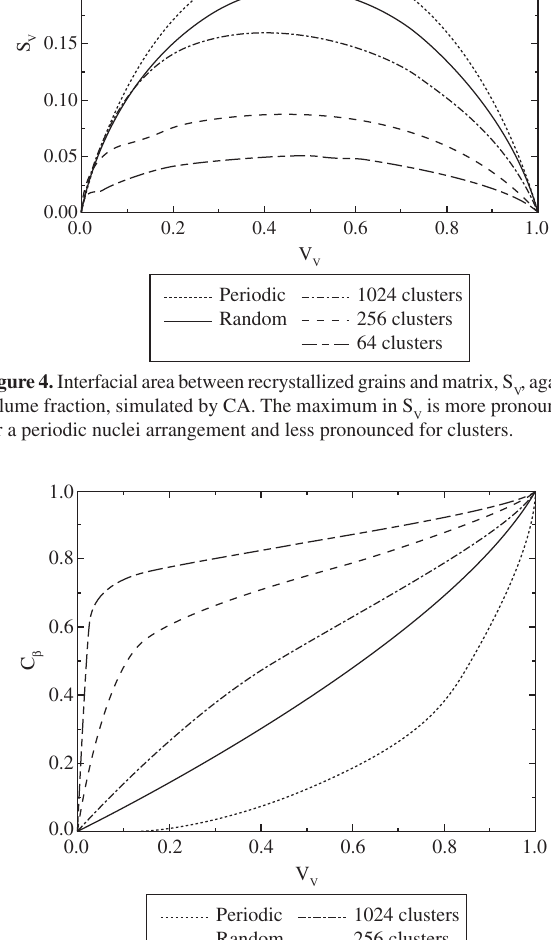
against volume fraction, simulated by β